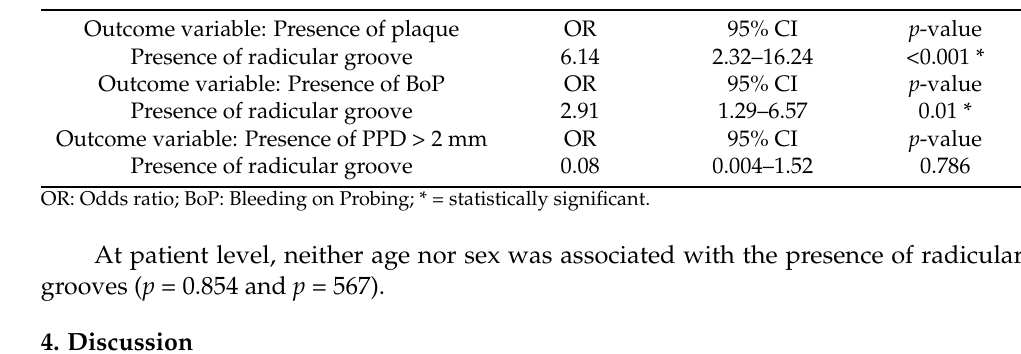
Table 3. Logistic regression with presence of radicular groove as dependent